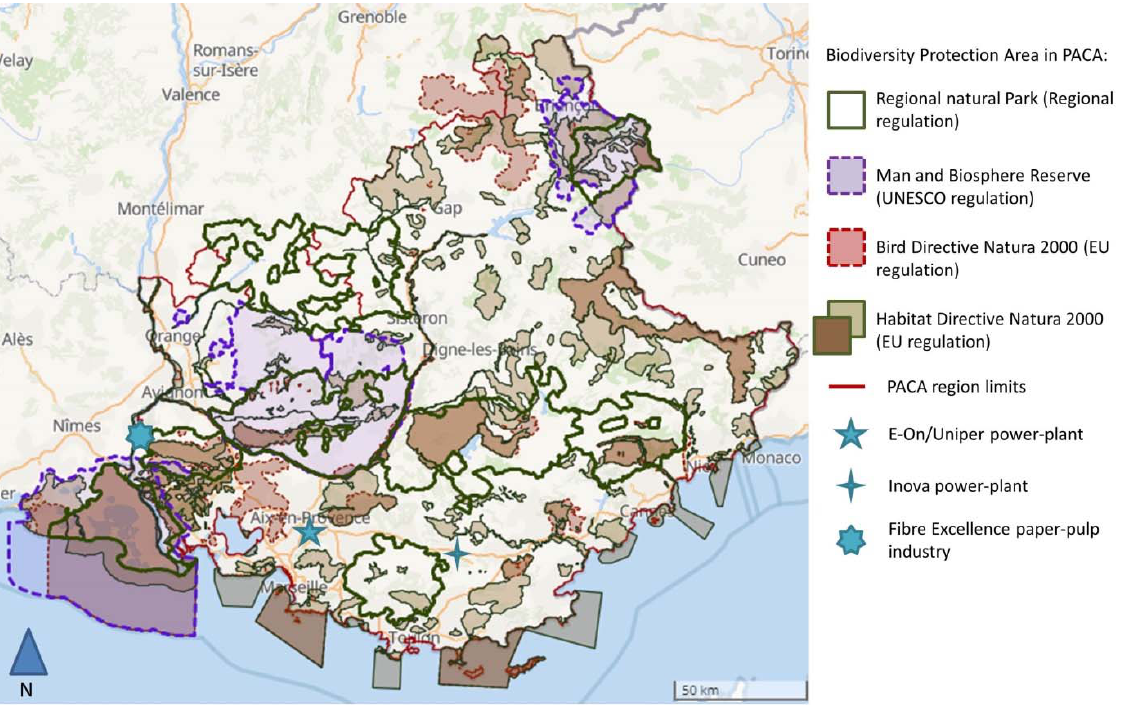
Figure 1. Map of PACA environmental regulations decided at upper scales (global scale: man and biosphere reserve labelled by UNESCO; European scale: Natura 2000 area; National and regional scales: Regional Natural Parks) and location of the three main industrial actors (E-On/Uniper, Inova and Fibre Excellence). Map edited from the online Regional Natural Park database for geographical information system (SIT PACA Database).